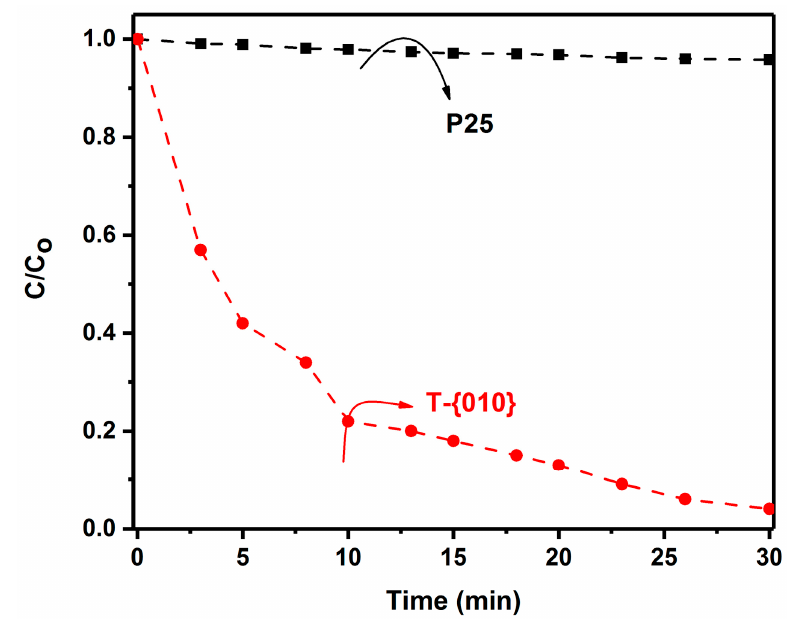
Figure 5. Gravity-settling of P25 and T-{010} over 30 min.